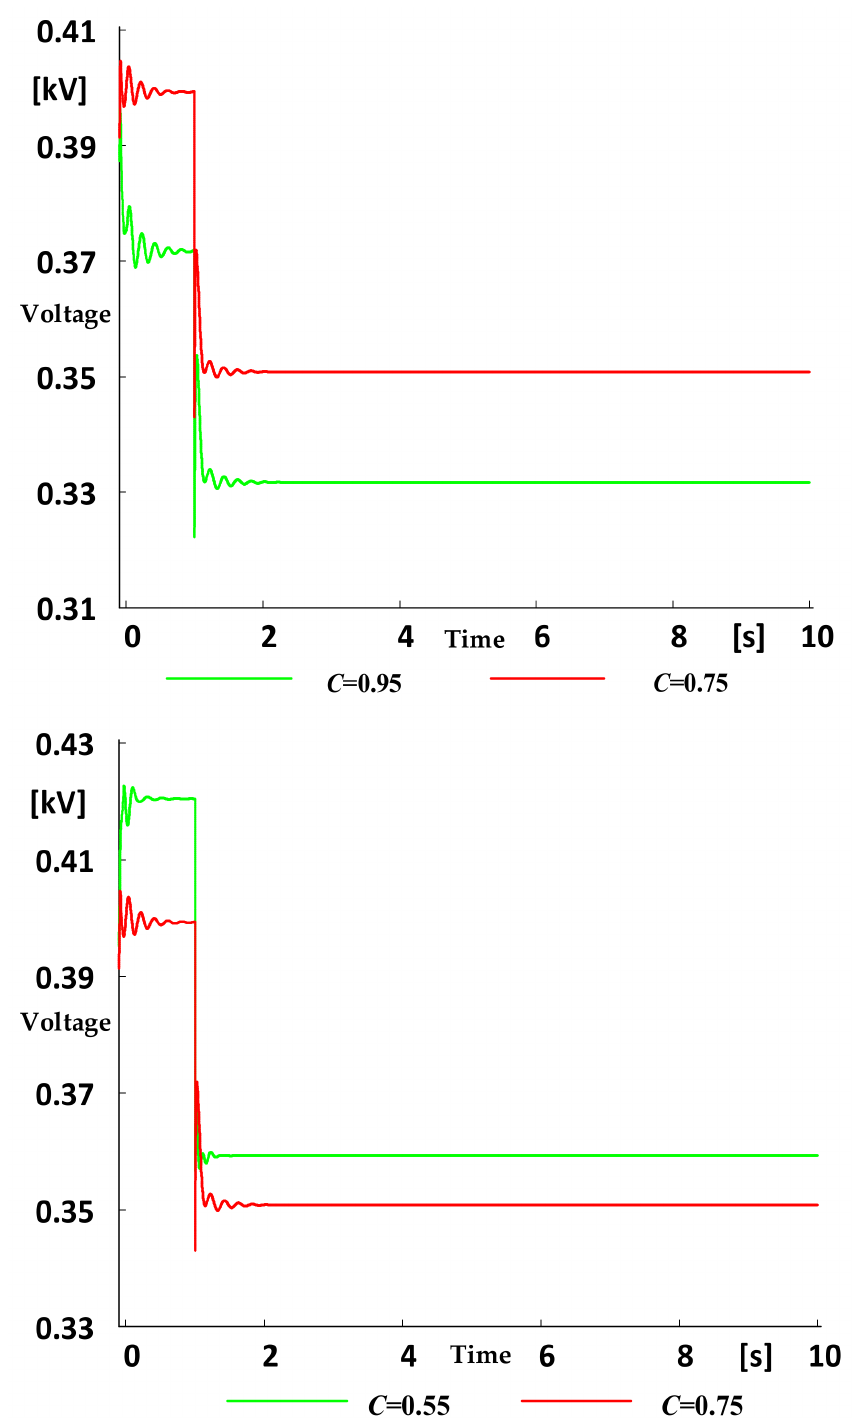
Figure 11. DC bus voltage waveform with different C. The simulated waveforms of DC voltage at D of 0.95, 0.75, and 0.55 are shown in Figure 12 below. It can be seen that as the D , i.e., D r , increased, the voltage dip increased slightly, and the stability became